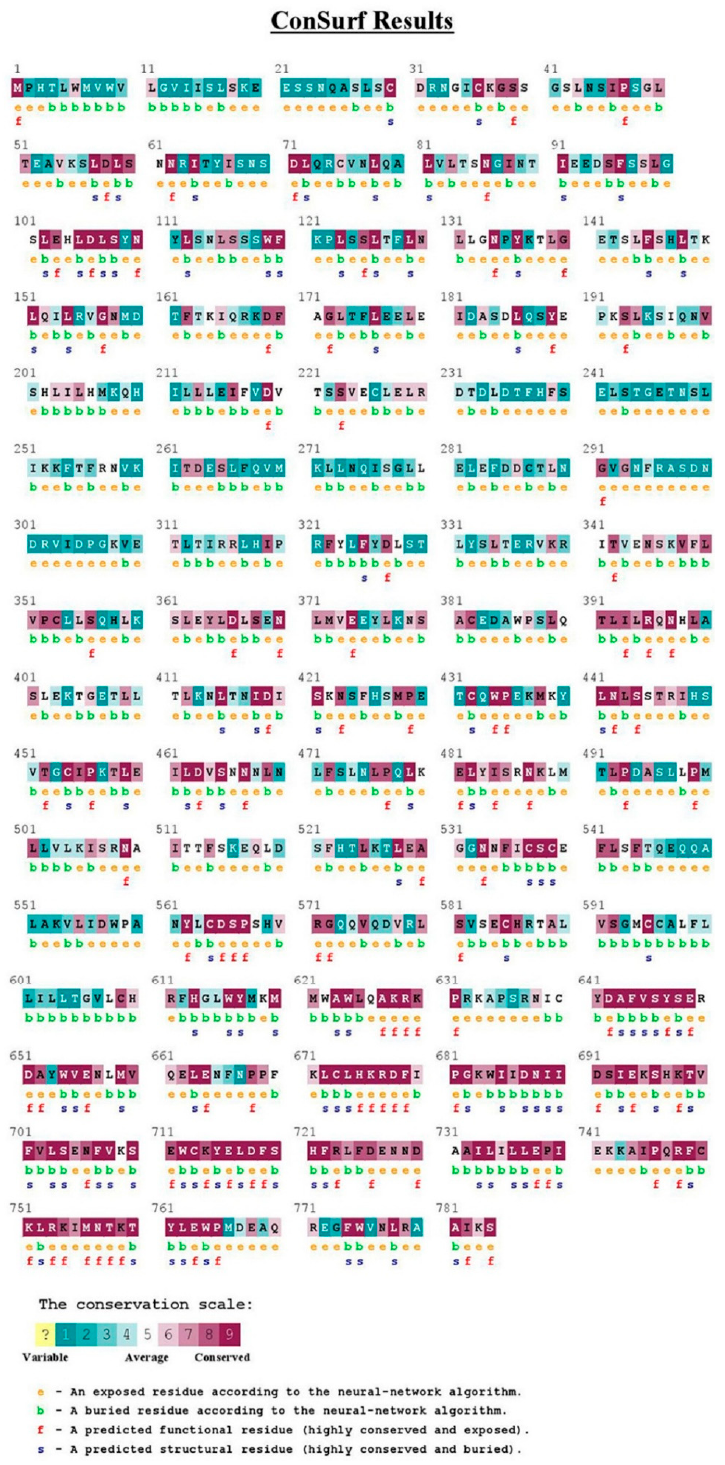
Figure 4. Evolutionary conservation analysis of TLR2 by Consurf.